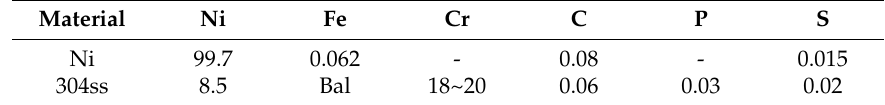
Table 2. Laser welding parameters. Table 1. Chemical compositions of Ni and 304ss (automatic fraction (%)).